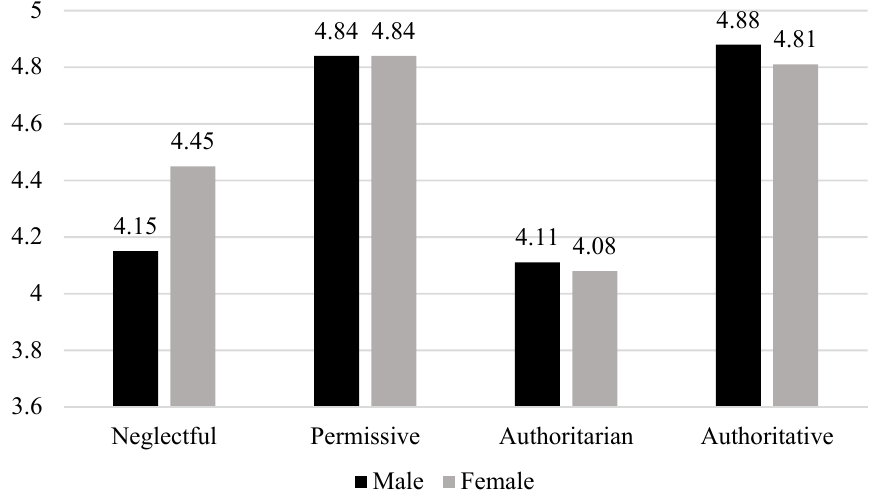
Figure 5. Relations between parenting styles and wellbeing in males and females.